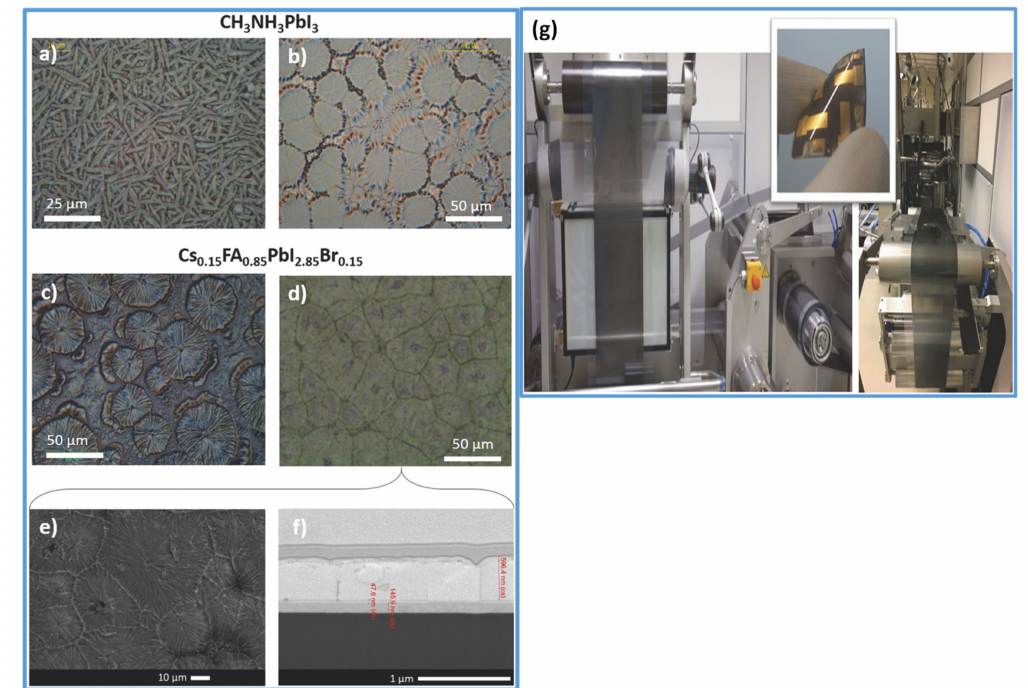
Figure 9. ( a , b ) The microstructures of the CH 3 NH 3 PbI 3 layer dried at 140 ◦ C with slow and fast temperature ramping, respectively. ( c , d ) Cs 0.15 FA 0.85 PbI 2.85 Br 0.15 layer dried with slow and fast temperature ramping, respectively. ( e ) The SEM image of perovskite (Cs 0.15 FA 0.85 PbI 2.85 Br 0.15 ) layer. ( f ) Cross-sectional FIB–SEM image of SnO 2 and perovskite layers R2R coated on PET / ITO substrates, the perovskite layer Cs 0.15 FA 0.85 PbI 2.85 Br 0.15 dried with fast temperature ramping (corresponding to the images d , e ). ( g ) Photograph images of the roll-to-roll prepared perovskite layer (Cs 0.15 FA 0.85 PbI 2.85 Br 0.15 ) and an example of the manufactured flexible devices. Reproduced